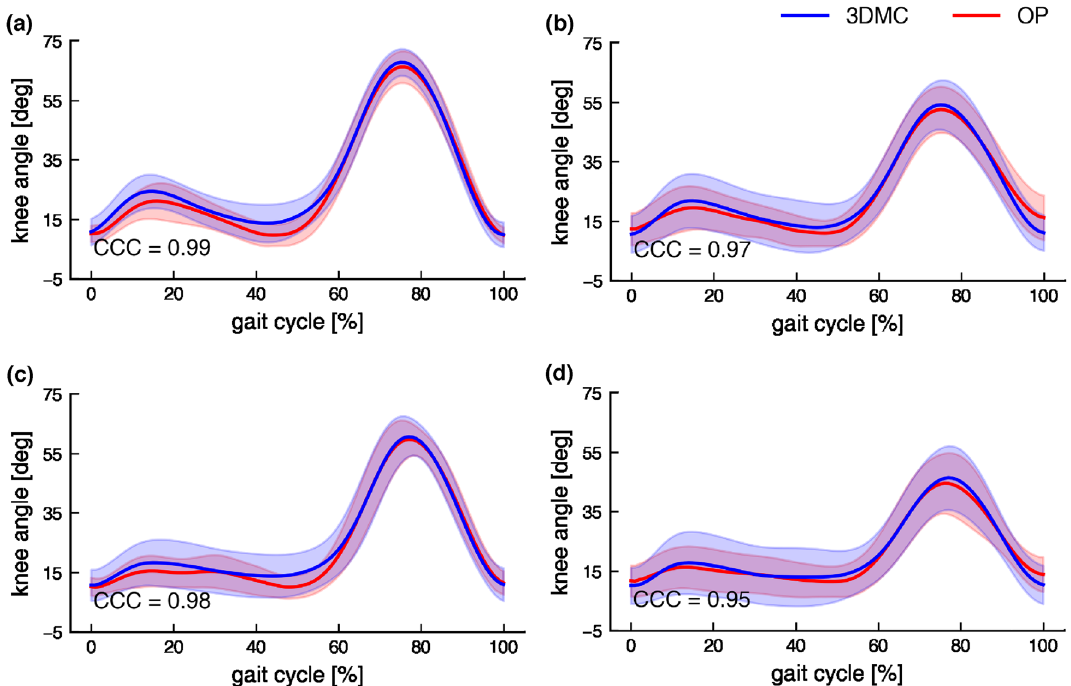
Figure 4. Knee angle by the two measurement methods. Self-selected speed with normal ( a ) and large FPA ( b ) condition. Slow speed with normal ( c ) and large FPA ( d ) condition. The shade is presented as 1 SD. Flexion is defined as